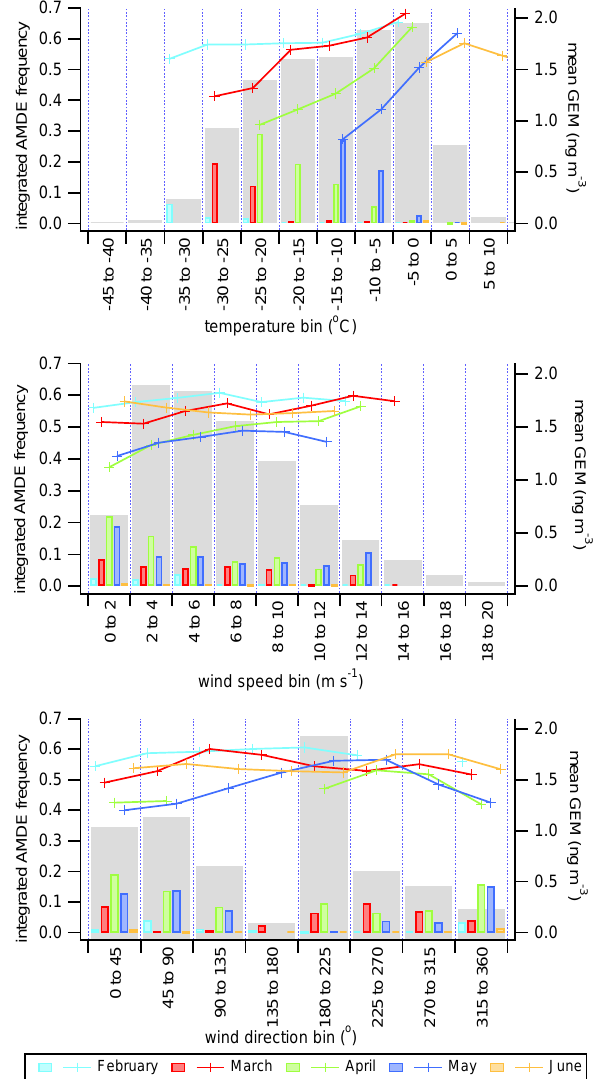
Fig. 3. Integrated atmospheric mercury depletion event frequency ( F AMDE ; coloured bars) and mean gaseous elemental mercury (lines), as a function of temperature, wind speed, wind direction and month for Amderma data 2001–2007. For reference, spring- time frequency histograms of the observed meteorological parame- ters are included in